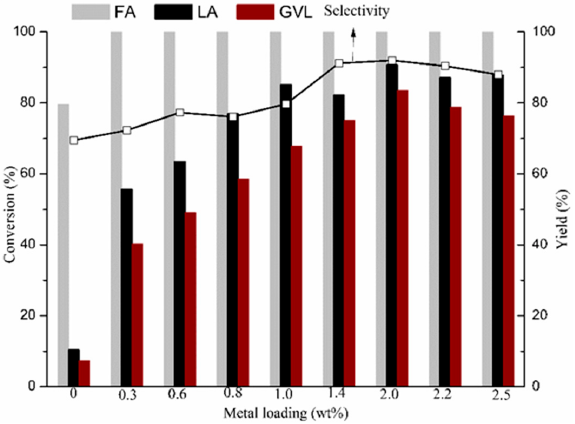
Figure 6. The effect of Au loading on the conversion of LA to GVL at 240 ° C for 2 h.